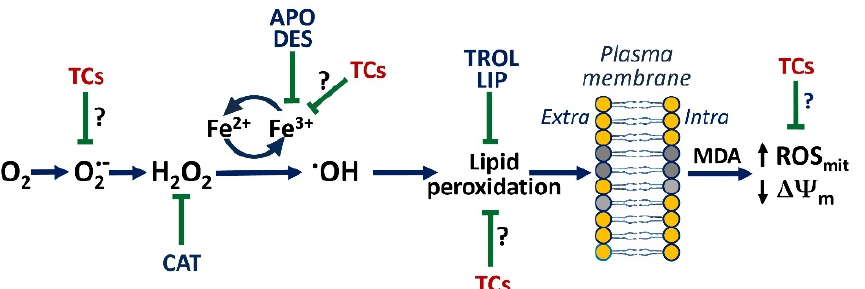
Figure 11. Schematic drawing showing how TCs may prevent the spontaneous loss of DA neurons induced by ferroptosis in midbrain culture. Under control conditions, soluble oxygen gives rise spontaneously to superoxide anions, which by dismutation produce H 2 O 2 [75], which in turn is converted into • OH through a Fenton-type reaction requiring Fe 2+ as catalyst [52,75]. • OH produced initially in the extracellular compartment stimulates lipid peroxidation on the outer side of the plasma membrane. The nature of downstream signaling events stimulating mitochondrial ROS production and promoting mitochondrial membrane depolarization remains to be established but MDA, a major by-product of lipid peroxidation of cell membranes [65], can produce both types of perturbations [66]. Neuroprotection by TCs could be due to superoxide scavenging, iron chelation, or the inhibition of lipid peroxidation propagation [63,64], with these mechanisms not mutually exclusive. The neuroprotective effects of TCs are mimicked by ferric iron chelators (APO; DES), which prevent iron to redox cycle, by the H 2 O 2 detoxifying enzyme CAT, which inhibits the formation of • OH, and by inhibitors of lipid peroxidation/ferroptosis (TROL, LIP), which protect the plasma membrane from the attack of • OH. The effects of TCs are, however, not mimicked by VitC, a water-soluble